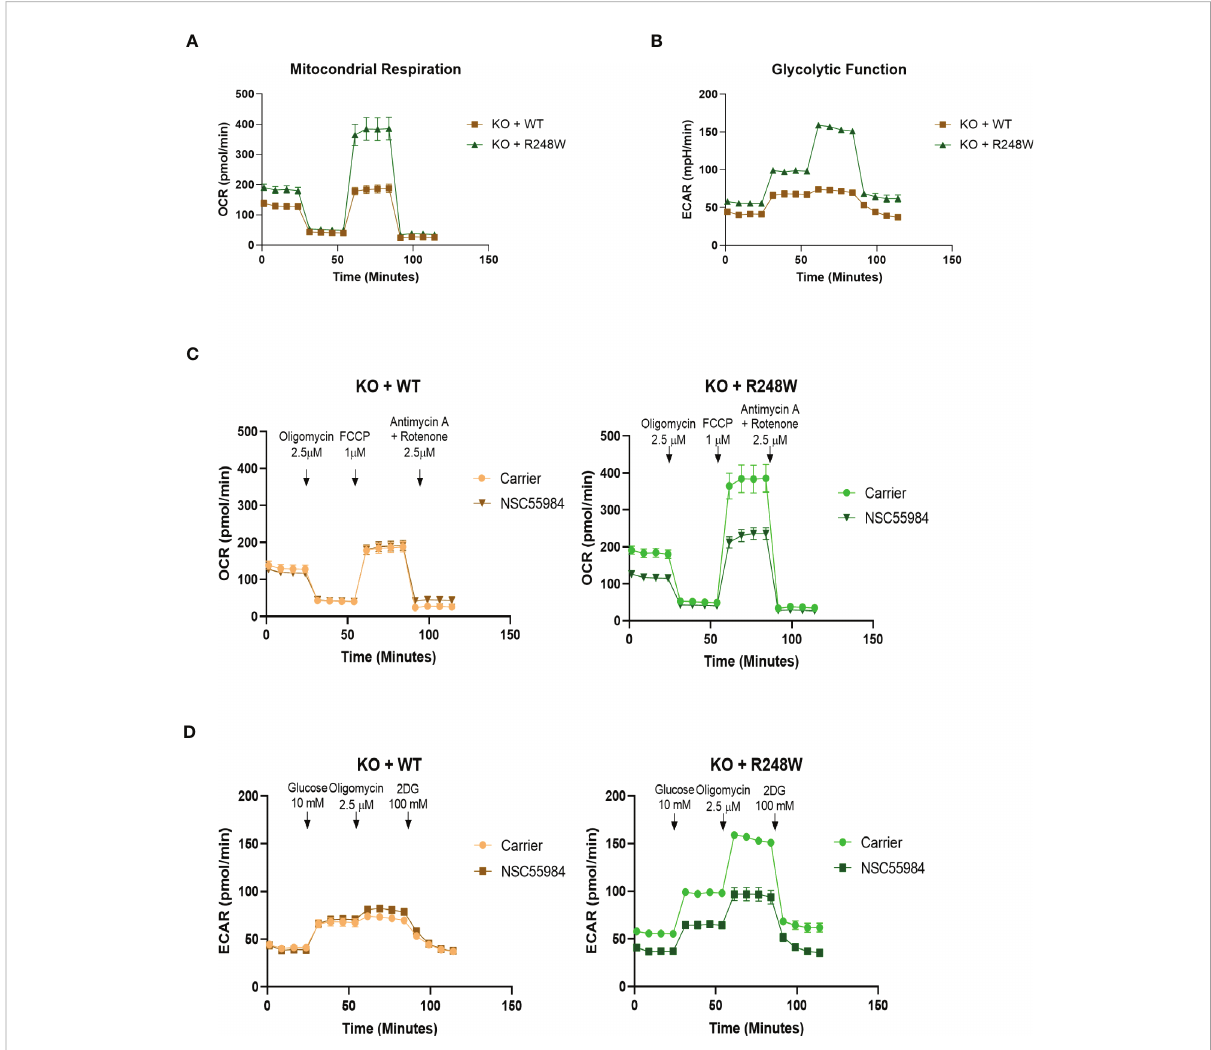
FIGURE 3 Isogenic cells match the parental cell lines. (A) Basal mitochondrial respiration, as measured with the Seahorse XF e 96 Cell Mito Stress Test Kit, in p53-expressing KO cells. Arrows indicate addition of metabolism-modulating drugs. (B) Basal glycolytic function, as measured with the Seahorse XF e 96 Glycolytic Stress Test Kit, in p53-expressing KO cells. Arrows indicate addition of metabolism-modulating drugs. (C) Mitochondrial function was measured using the Seahorse XF e 96 Cell Mito Stress Test Kit following treatment with NSC59984 (12 m M) for 72 hr in p53- expressing KO cells. (D) Glycolytic function was measured using the Seahorse XF e 96 Glycolytic Stress Test Kit following treatment with NSC59984 (12 m M) for 72 hr in p53-expressing KO cells. * = 0.05, ** = 0.005, *** = 0.0005, **** =